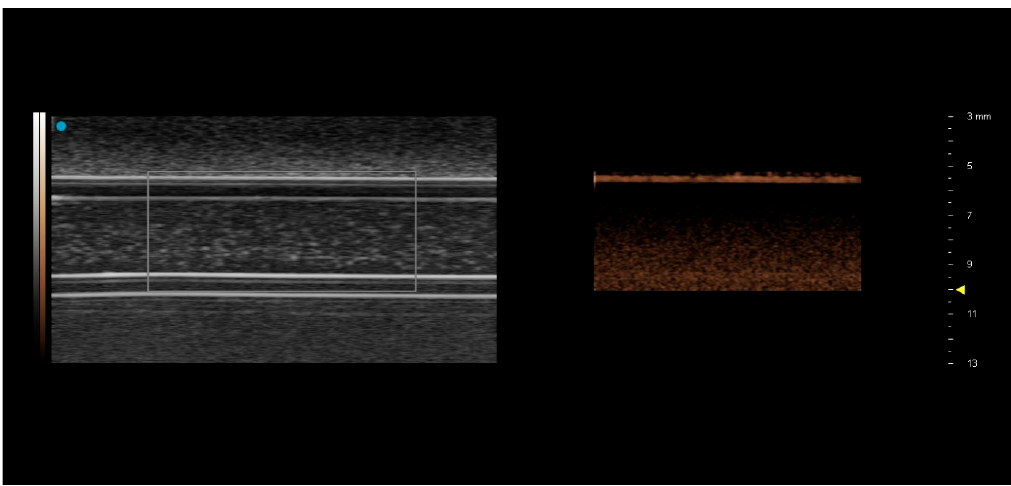
Figure 4. Images acquired using the Vevo 3100 MX250 preclinical ultrasound probe from 3.2 mm diameter tubing at 1.0 cm depth. Tubing is filled with SonoVue. Only the superficial layer of the tube can be visualized in the contrast-specific imaging mode image on the RHS.